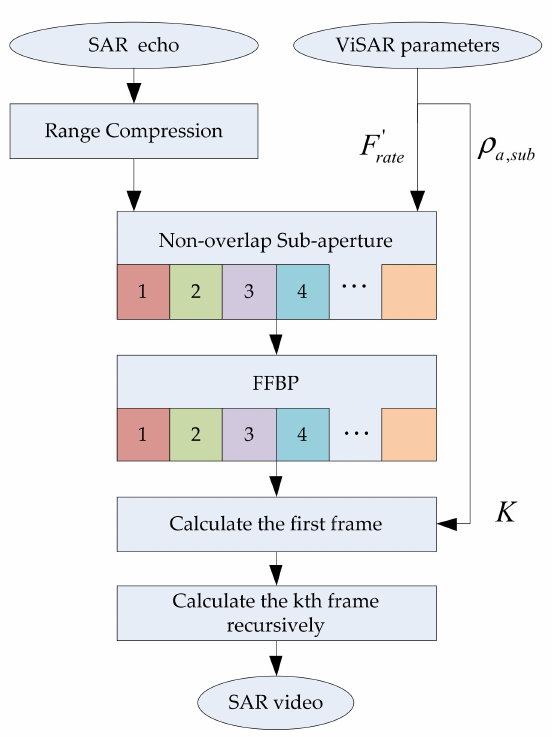
Figure 8. FFBP based SAR video formation processing